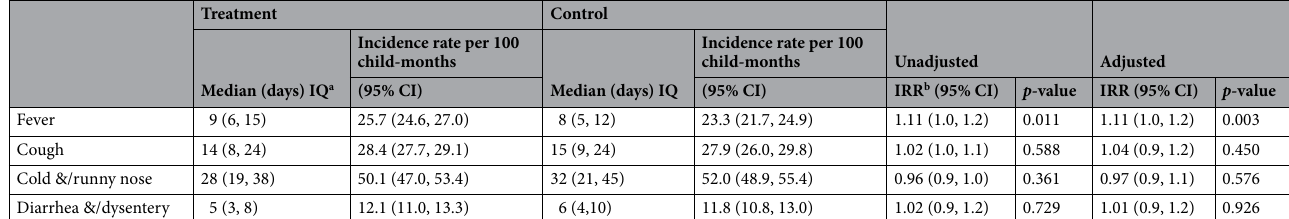
Table 5. Effects of the intervention on childhood morbidities over the entire 12 months. a Inter quartile range. b IRR were estimated using Poisson regression with sandwich variance estimator at the cluster level. The dependent variable was number of episodes of illness during follow-up (0–12 months follow-up); the offset was the log total number of events during follow-up. Adjusted for age, sex, child’s baseline length, mother’s height, household asset index, and study group; the control group was treated as the